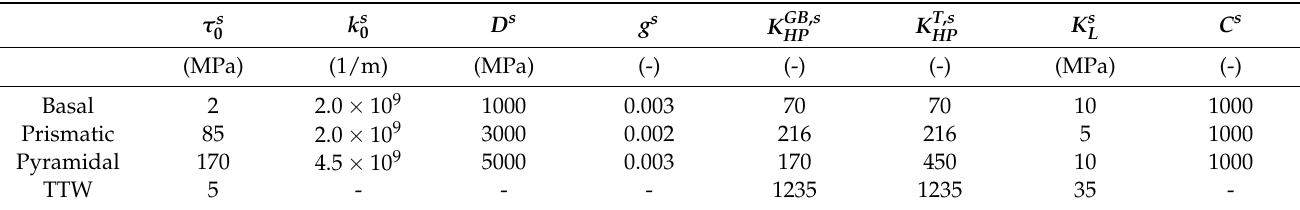
Table 1. Calibrated and validated parameters of the employed dislocation-density-based hard- ening model with explicit grain size and Y-content dependence. Here, τ s (Equations (2) and (7)). k s , D s , and g s are the dislocation generation rate (Equation (A3)), drag 0 stress (Equation (A2)), and normalized activation enthalpy (Equation (A2)). K GB , s Hall–Petch coefficients for grain and twin boundaries, respectively (Equation (5)). K s strengthening coefficient (Equation (6)). C s is the pre-factor twin-induced reduction in dislocation trapping rate (Equation